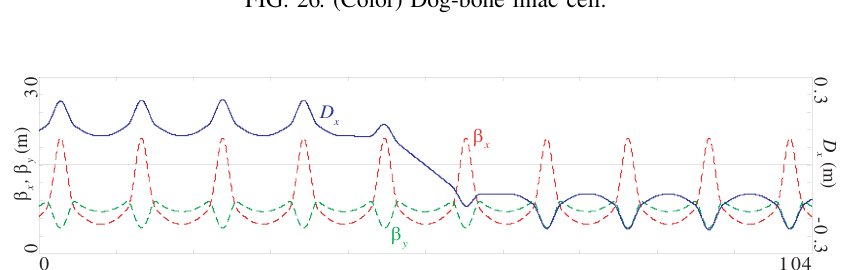
FIG. 26. (Color) Dog-bone linac cell.